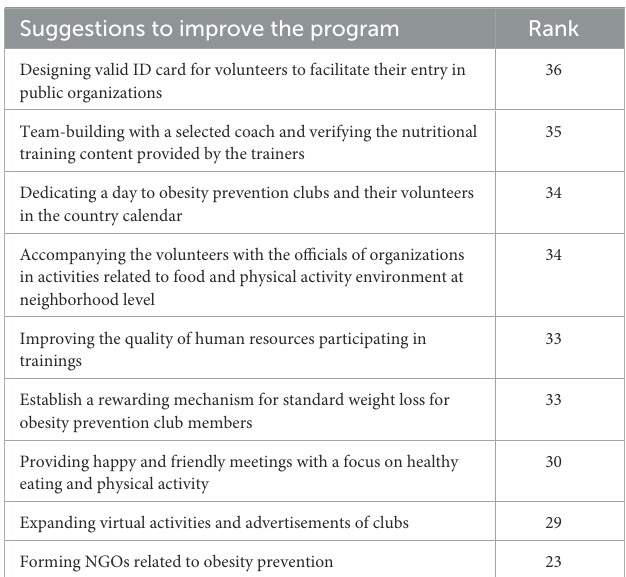
TABLE 3 Stakeholder’s suggestions and their ranking regarding improvement of the function of municipality health clubs in obesity prevention and improving participation (based on the focus group discussion